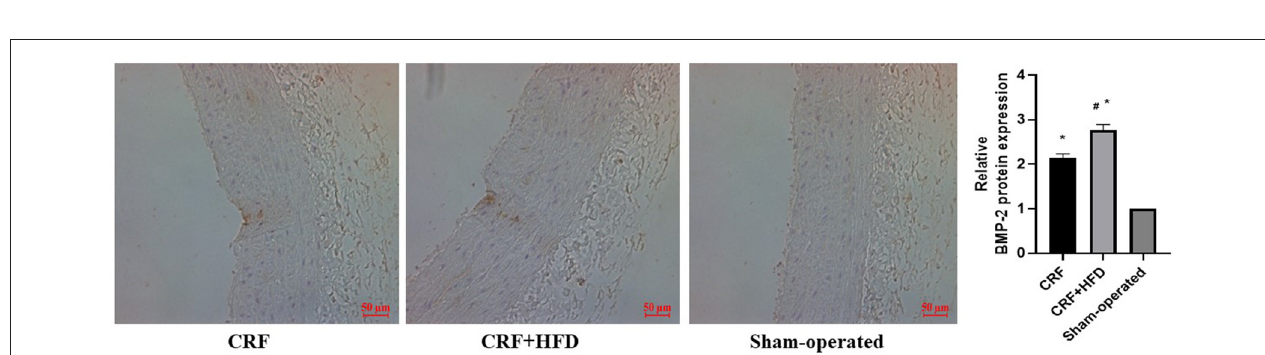
FIGURE 5 | Immunohistochemical staining of BMP-2 protein expression in aortas of rats in each group. Six rats were included in each group. The BMP-2 protein staining of the aortic wall was light brown fine granular. * P < 0.05 vs. sham-operated group; # P < 0.05 vs. CRF group. CRF, chronic renal failure; HFD, high fat diet.